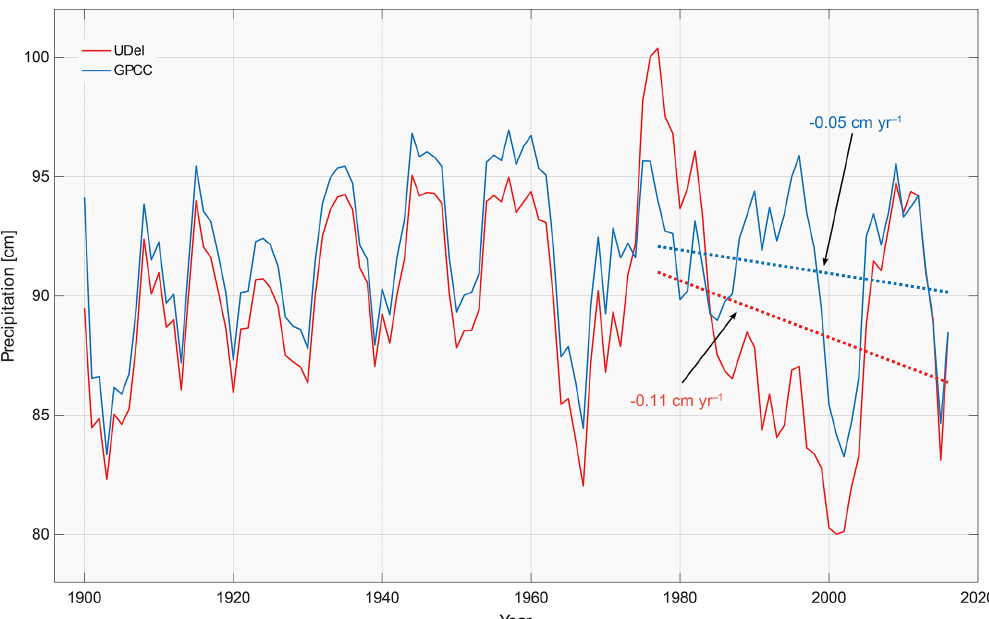
Figure 1. Average cumulative summer (JJAS) precipitation [cm] over land in all of India from 1900 to 2016 for two observational datasets: (red) University of Delaware (UDel; Willmott and Matsuura, 2001) and (blue) the Global Precipitation Climatology Center (GPCC; Schneider et al., 2018). Data are smoothed using a moving mean with a window size of 5 years. Linear trend lines are indicated for the last 40 years for each dataset as dashed lines, and the slopes [cmyr − 1 ] are denoted by the